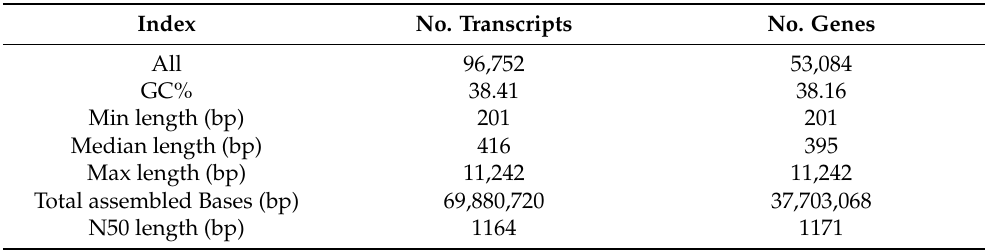
Table 2. Assembly of the transcripts and genes from transcriptome sequencing data of S. furcifera females. Index